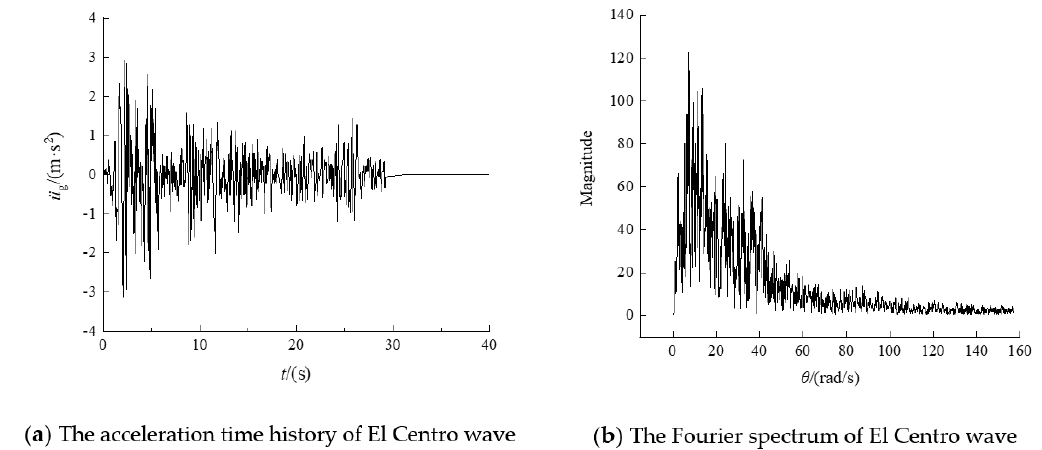
Figure 6. The acceleration time history and Fourier spectrum of El Centro wave.